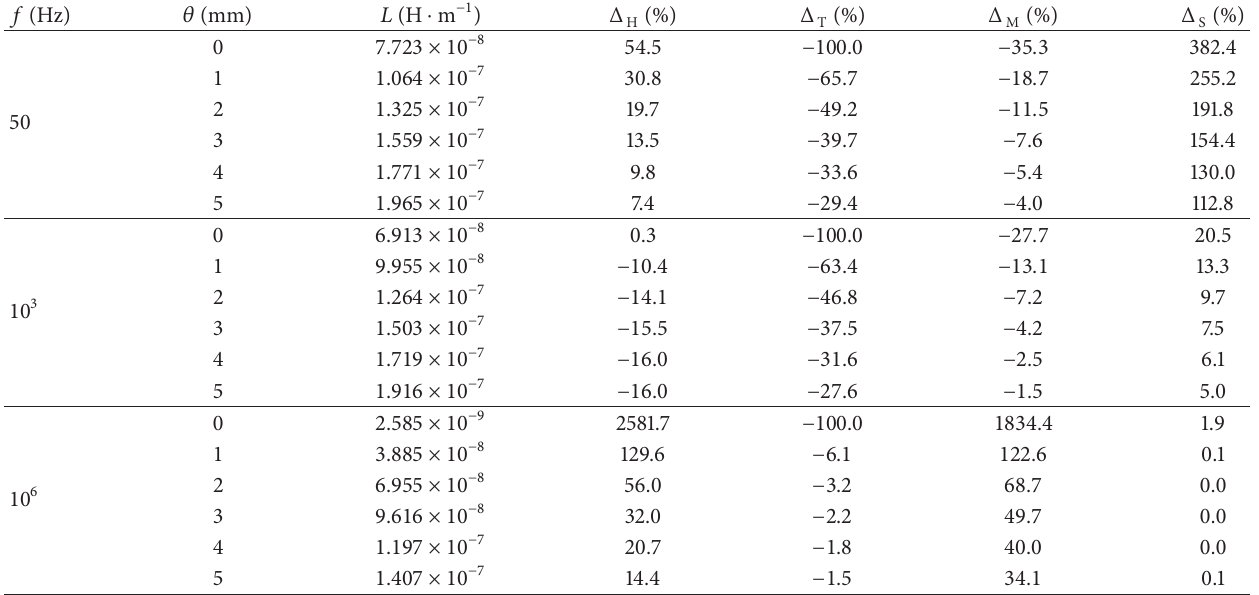
Table 4: Comparison of inductances for a pair of coaxial copper conductors, 𝑟 𝑖0 = 0 mm, 𝑟 𝑖𝑛 = 5 mm, 𝑞 = 1 . 𝑓